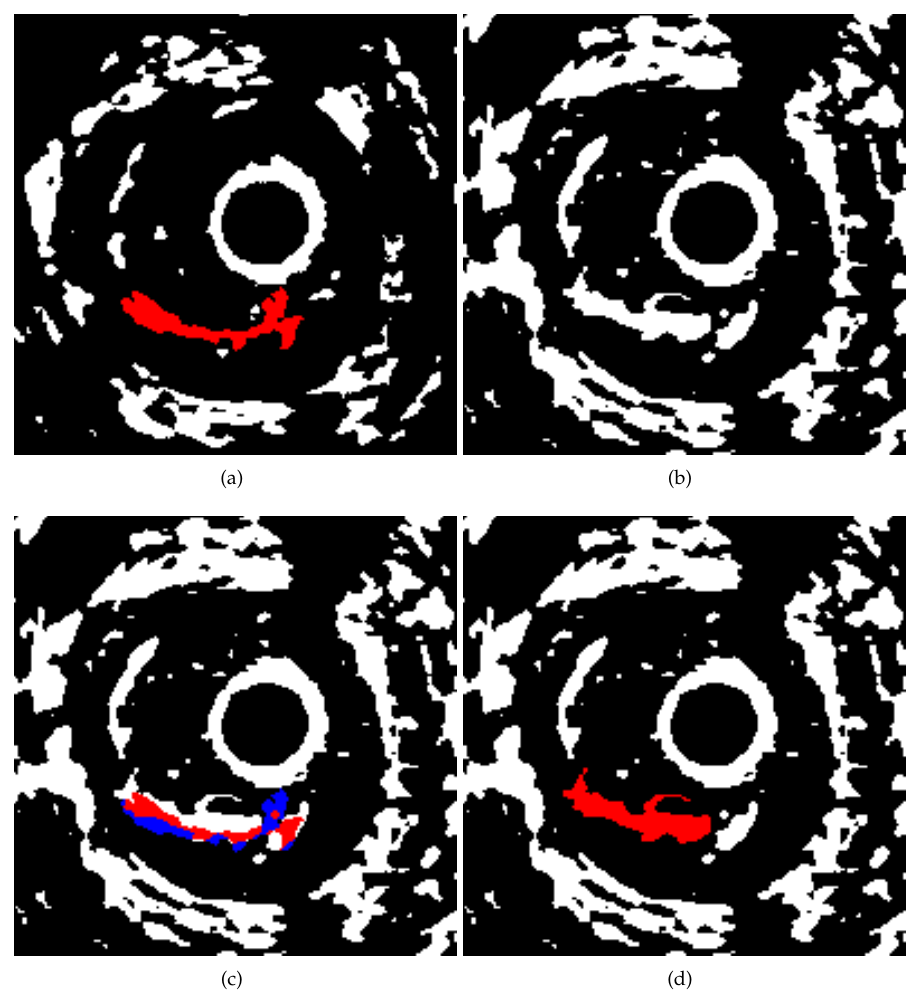
Figure 6. ( a ) Binarised image in the first cross sectional image with the ateroma selected in red; ( b ) Binarised second image in the search region; ( c ) Binarised image with the pixels selected in the previous steps overlapped (red: the pixel is binarised and selected in the previous step, blue: the pixel is not binarised and was selected in the previous step); ( d ) Selected region according to the maximum number of